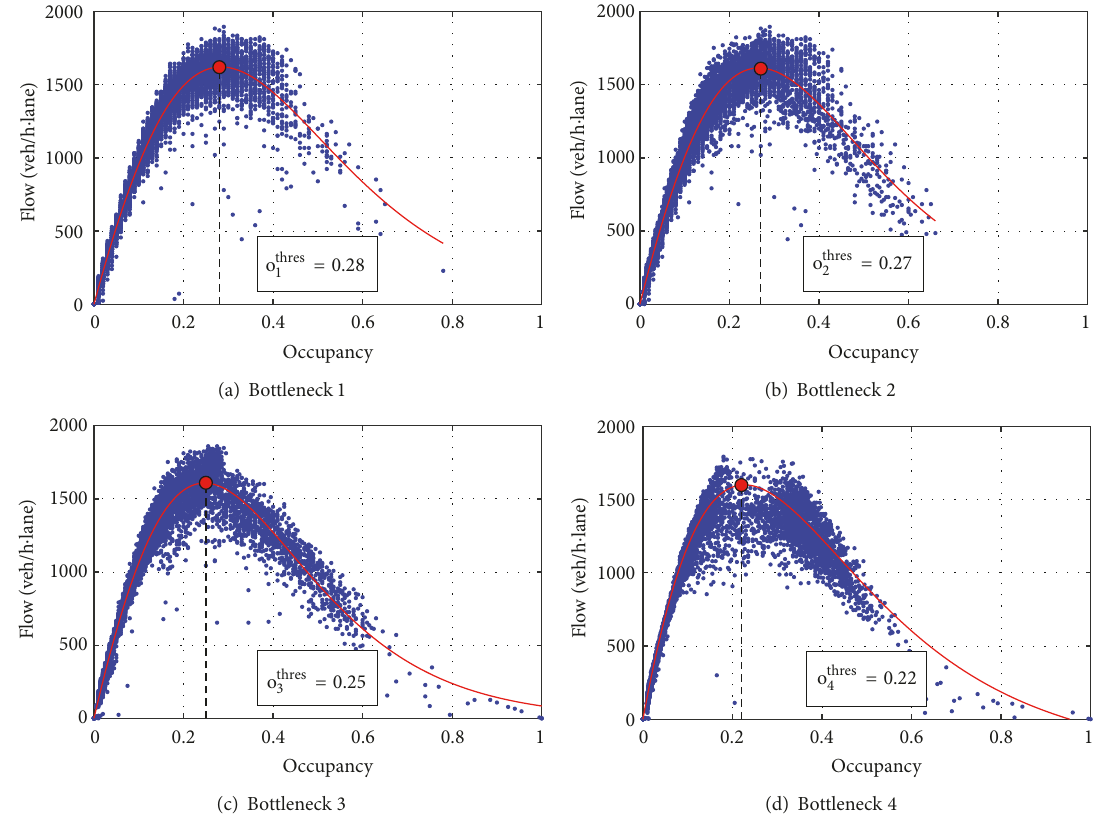
Figure 8: The relationship between occupancy and flow volume at four bottleneck sections.